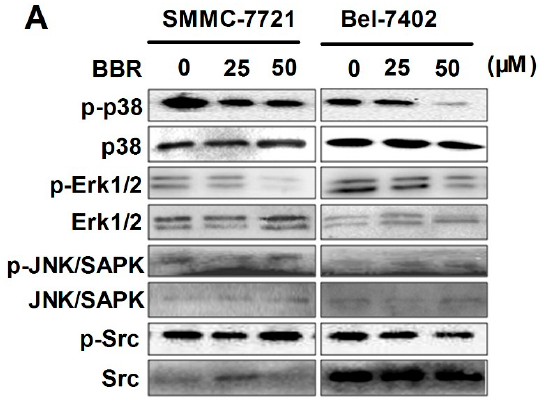
Figure 6. Cont. Figure 6. Cont.